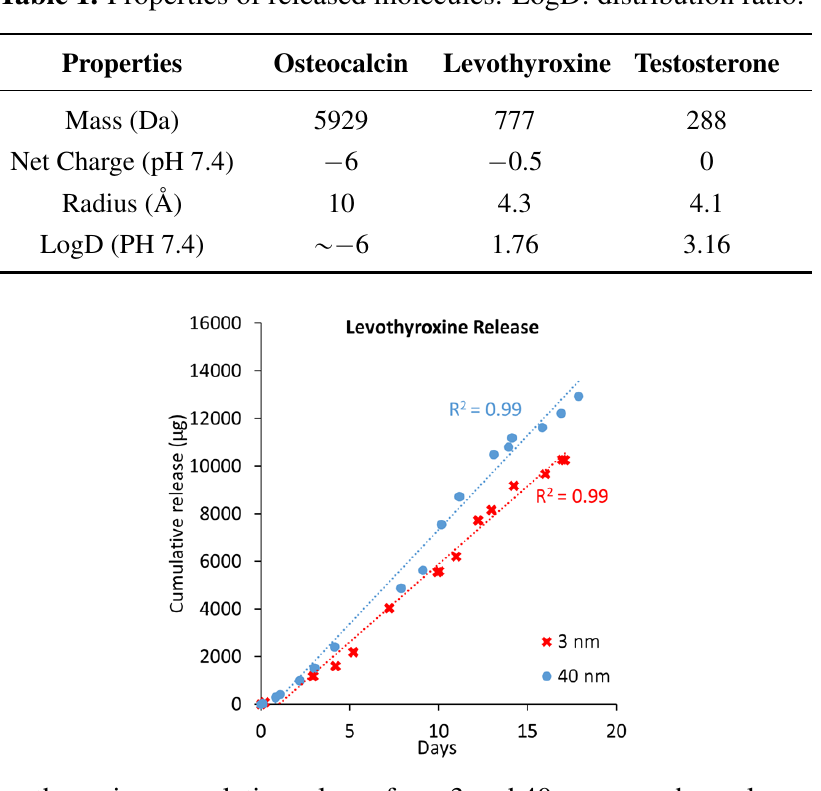
Figure 1. Levothyroxine cumulative release from 3 and 40 nm nanochannel membranes and their linear fits (blue and red dotted lines).